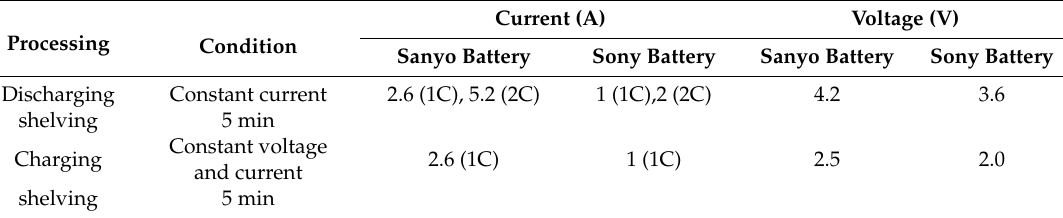
Table 3. Design of charging and discharging experimental